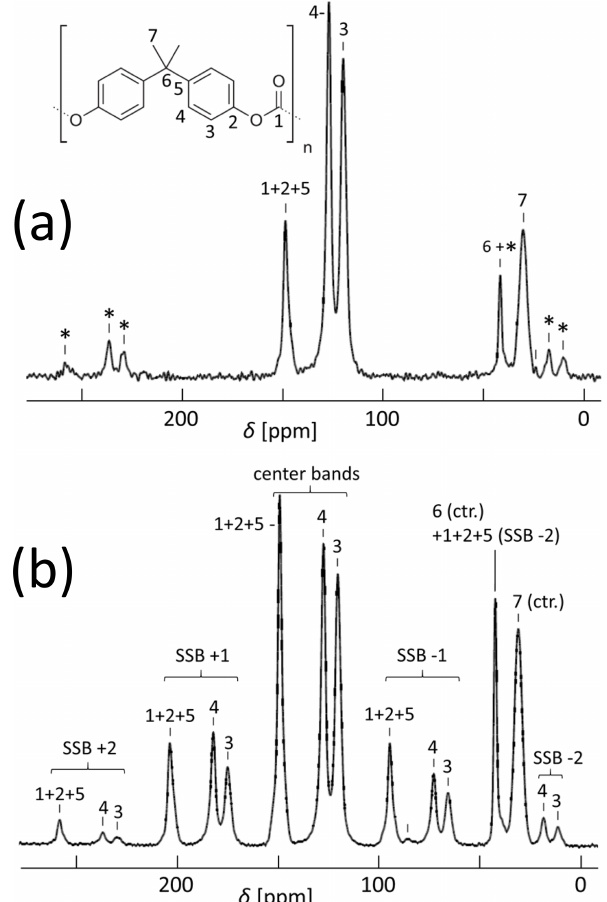
Figure 5. 13 C CP MAS spectra of an isotropic PC sample with (a) 11kHz and (b) 5.5kHz spinning; for the resonance assignment, see Williams et al. (1977). SSBs are marked by asterisks. The spec- trum in (b) was taken with 20000 scans.